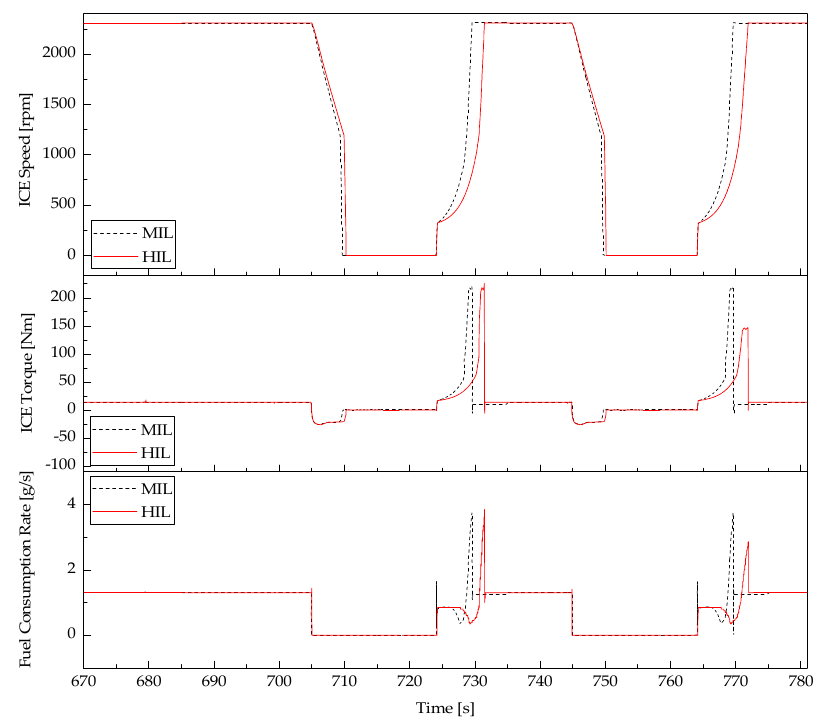
Figure 13. Comparison of ICE dynamics of MIL and HIL tests during cycle 7th.